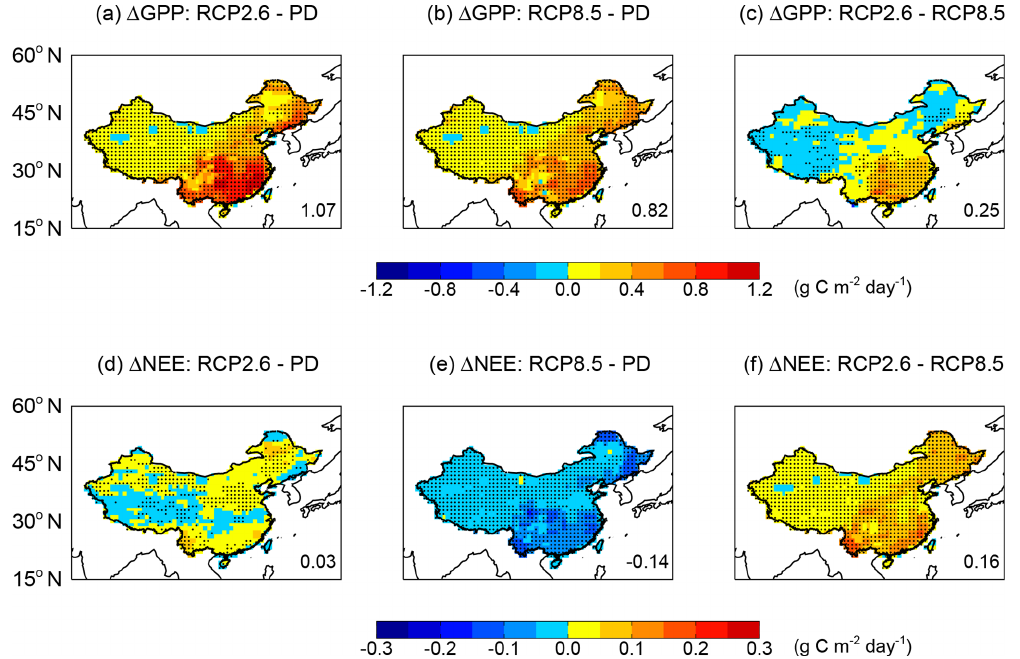
Figure 5. Changes in carbon fluxes by global warming of 1.5 ◦ C. Results shown are simulated (a–c) GPP and (d–f) NEE over China between the period of global warming of 1.5 ◦ C and present day (1995–2015) under (a, d) RCP2.6 scenario, (b, e) RCP8.5 scenario, and (c, f) their differences. The period of global warming of 1.5 ◦ C is set to 2050–2070 for RCP2.6 and 2021–2041 for RCP8.5. Simulations are performed using the YIBs vegetation model driven with daily meteorology from seven CMIP5 models. The O 3 damaging effect is included with predicted ensemble O 3 concentrations from 12 ACCMIP models. For each grid, significant changes at p < 0 . 05 are marked with dots. The total changes (PgCyr − 1 ) over China are shown in each